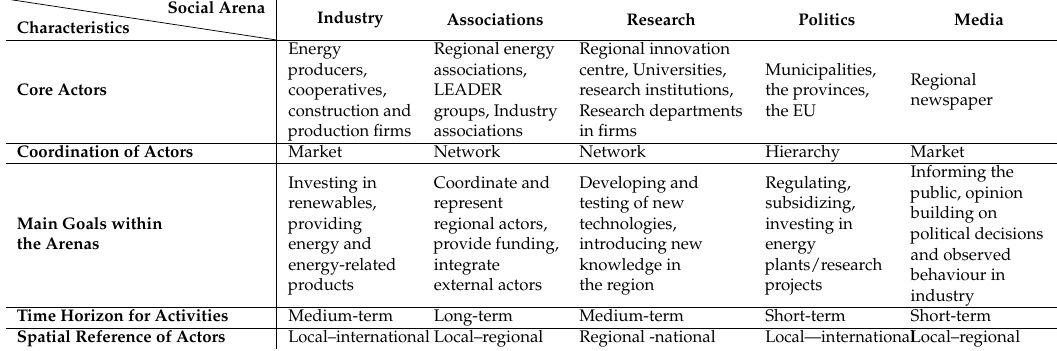
Table 4. Disparity attributes of arenas involved in the social subsystem in EWG (adapted from [61]).